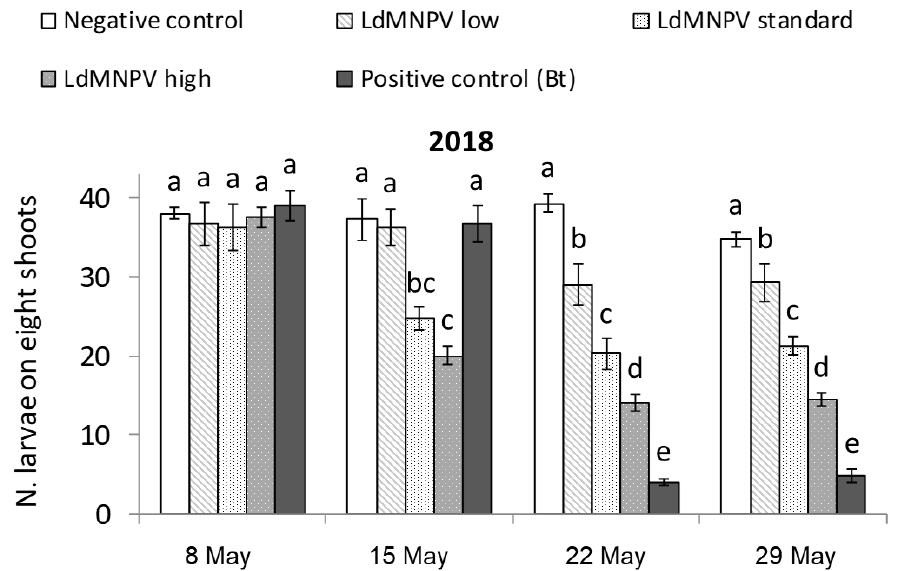
Figure 2. Larval density (mean ± SE) assessed by sampling 8 shoots/plot in the dose–response trial with LdMNPV applications from the ground in 2018. Different letters (a, b, c, d, e) above bars indicate significant differences among means within each sampling date (ANOVA Mixed Proc., LSMEANS, p < 0.05).